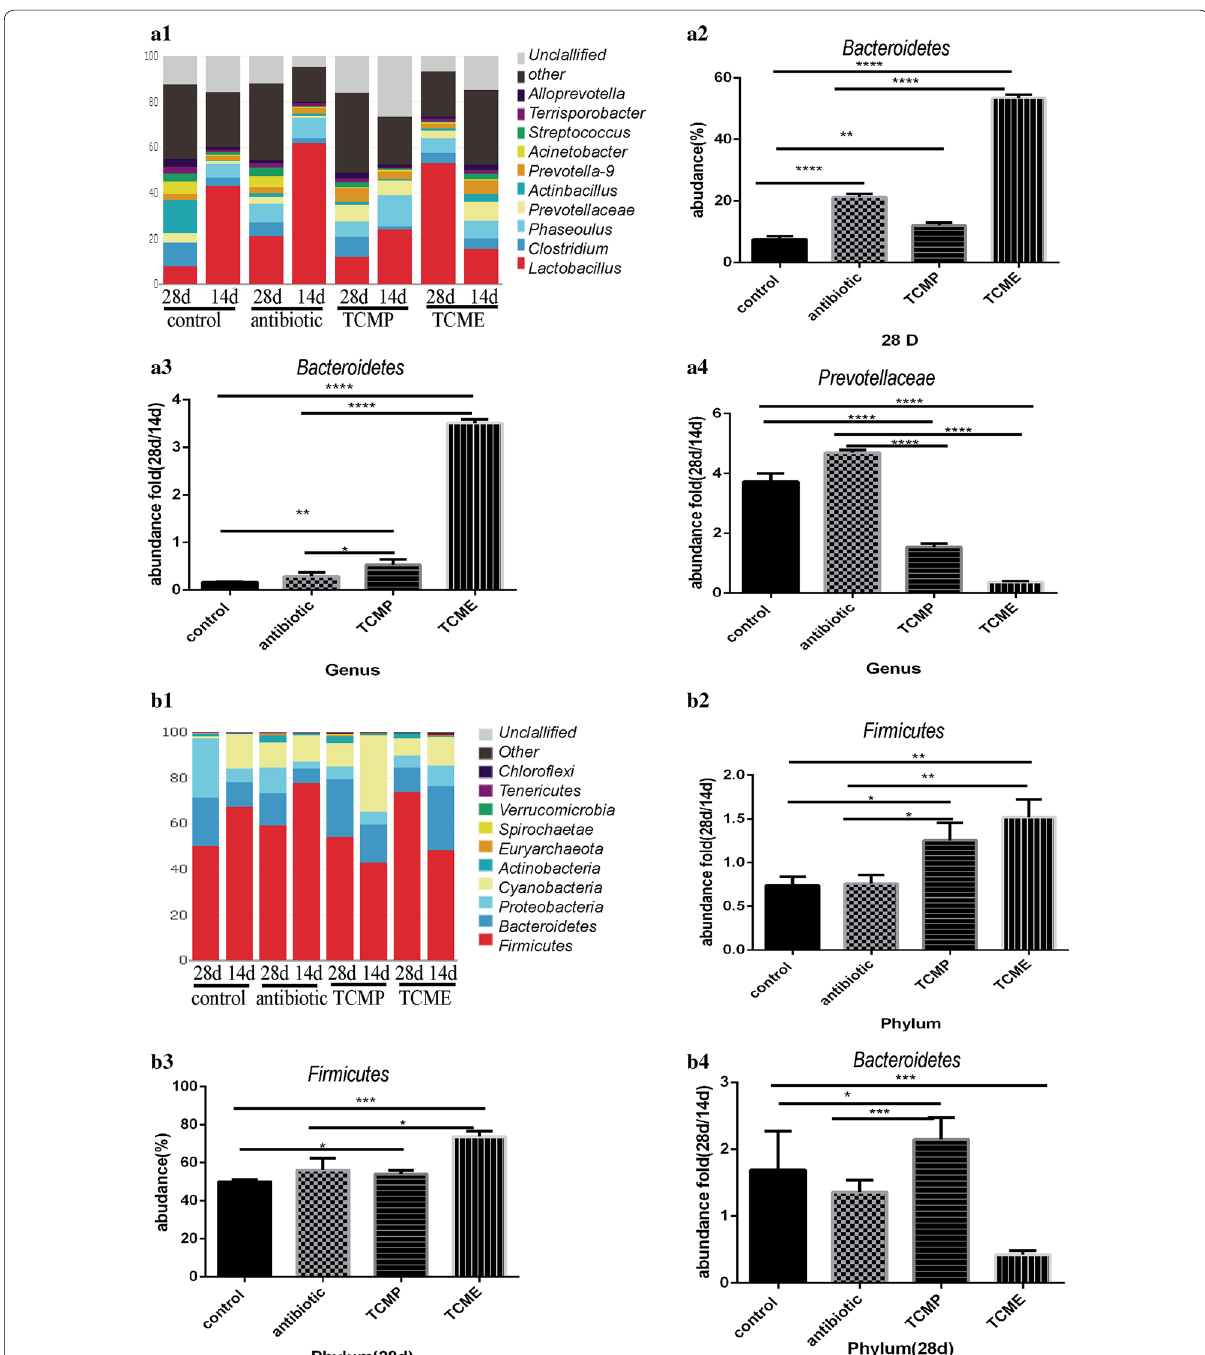
Fig. 5 Effect of coix seed on the composition of gastrointestinal microbiota with respect to genus and phylum. a1 Effect of coix seed on the composition of the gastrointestinal microbiota with respect to genus in weaned pigs. a2 Abundance of genus Bacteroidetes . a3 Fold abundance of genus Bacteroidetes (28D/14D). a4 Fold abundance of genus Prevotellaceae (28D/14D). b1 Effect of coix seed on the composition of the gastrointestinal microbiota with respect to phylum in weaned pigs. b2 Fold abundance of phylum Firmicutes (28D/14D). b3 Abundance of phylum Firmicutes . (b4) Fold abundance of phylum Bacteroidetes (28D/14D). (* p < 0.05; ** p < 0.02; *** p < 0.01, **** p <